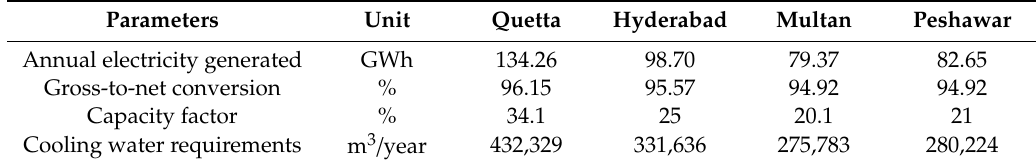
Figure 18. Electricity production by the 50 MWe LFR plant with evaporative cooling for different regions. Table 11. Performance parameters of 50 MWe LFR plant with evaporative cooling. Table 11. Performance parameters of 50 MWe LFR plant with evaporative cooling.